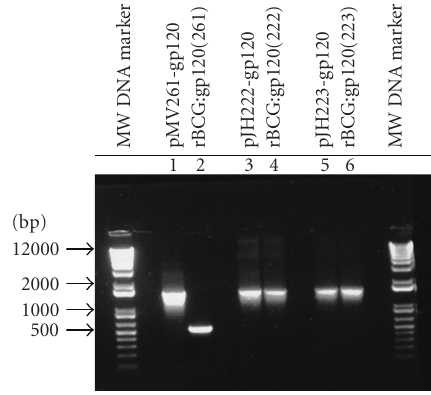
Figure 1: PCR analysis of the HIV-1gp120 gene cloned into pMV261, pJH222 and pJH223 vectors. Lane 1, 3 and 5 are PCR products of the HIV-1gp120 gene (1578 bp) cloned into pMV261 ( lane 1 ), pJH222 ( lane 3 ) and pJH223 ( lane 5 ) vectors, respectively. Plasmid DNA before BCG transformation (pre-BCG) were used as positive controls (lane 1, 3 and 5). Lane 2, 4 and 6 are PCR products from the rBCG:HIV-1gp120 (pMV261), rBCG:HIV- 1gp120 (pJH222) and rBCG:HIV-1gp120 (pJH223) colonies.